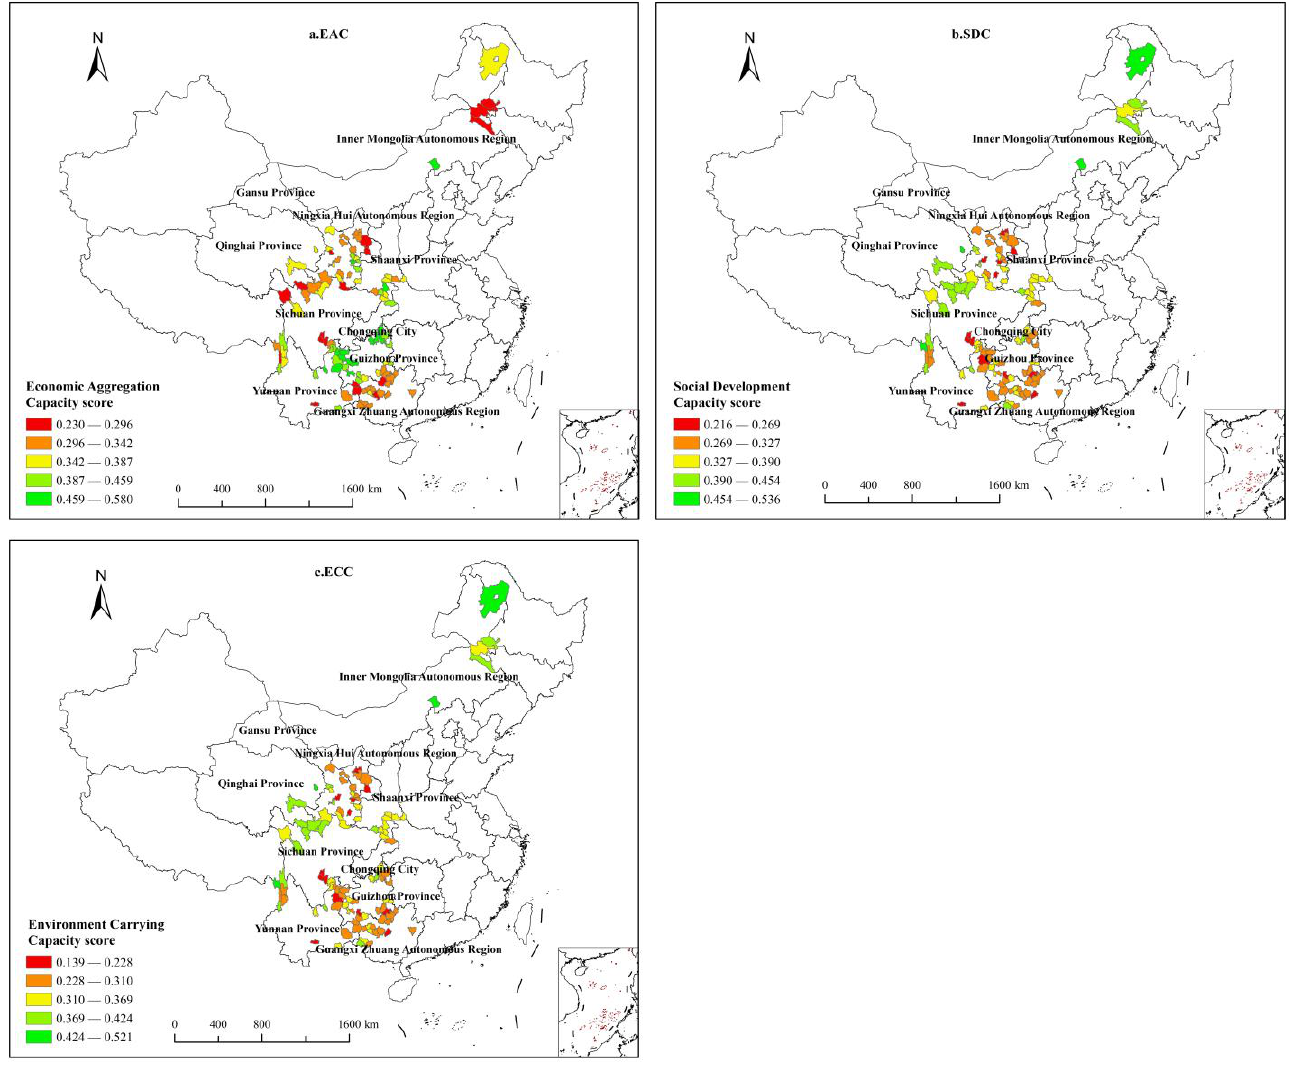
Figure 3. CSDC score of key counties to receive assistance according to the secondary